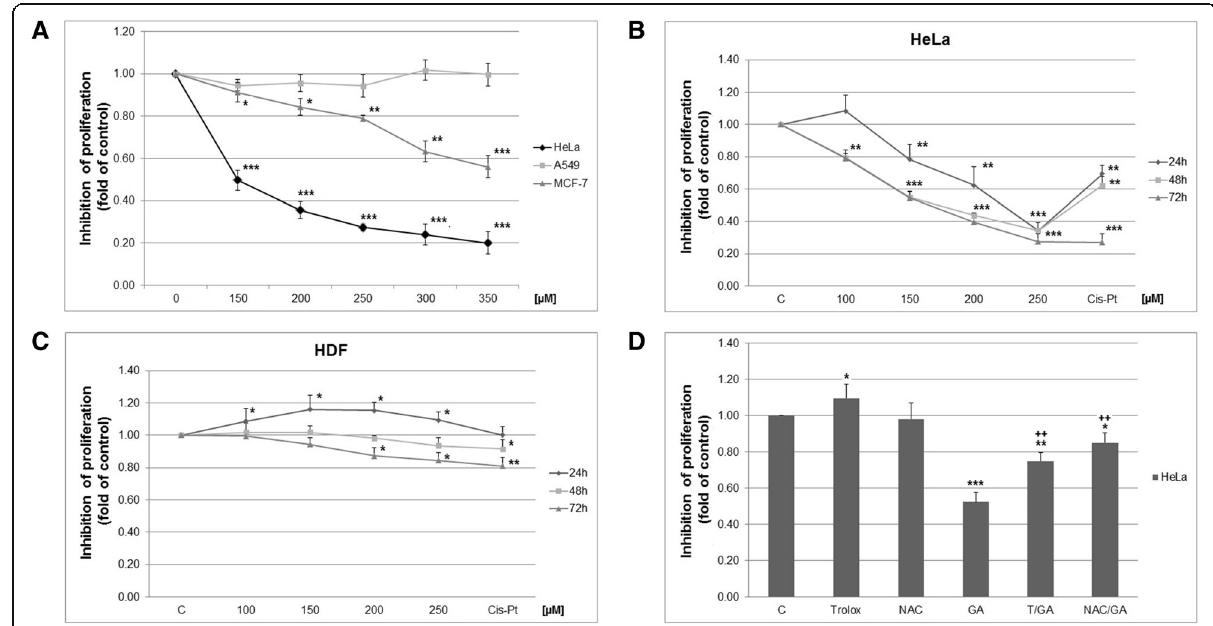
Fig. 1 a Effect of GA (72 h) on HeLa, MCF-7 and A549 cells proliferation; Time and dose-dependent analyses of HeLa ( b ) and HDF ( c ) cells proliferation using MTS assay. d HeLa cells proliferation affected by NAC/Trolox pre-treatment on 72 h. Data are presented as mean ± SD from 3 independent experiments. Significance: * P < 0.05, ** P < 0.01, *** P < 0.001 versus untreated cells (control); ++ P < 0.01, versus